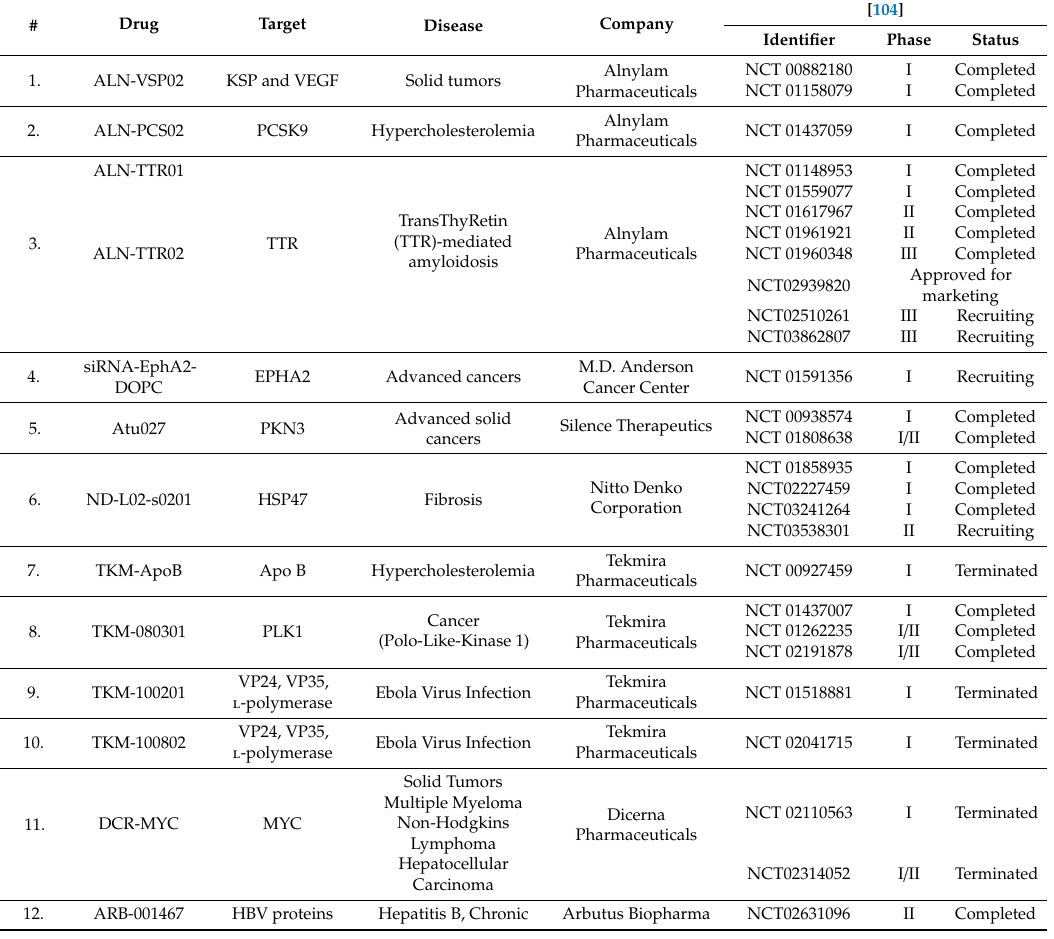
Table 1. The siRNA-lipid delivery systems used in clinical